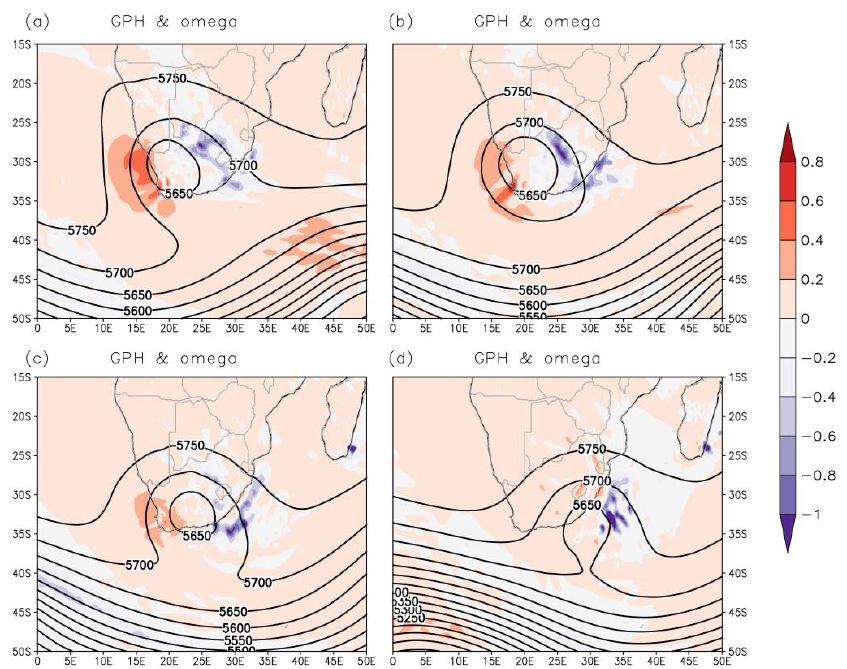
Figure 9. Geopotential height (m) and omega (Pa/m) at 500 hPa during ( a ) 22, ( b ) 23, ( c ) 24, ( d ) 25 April 2019.